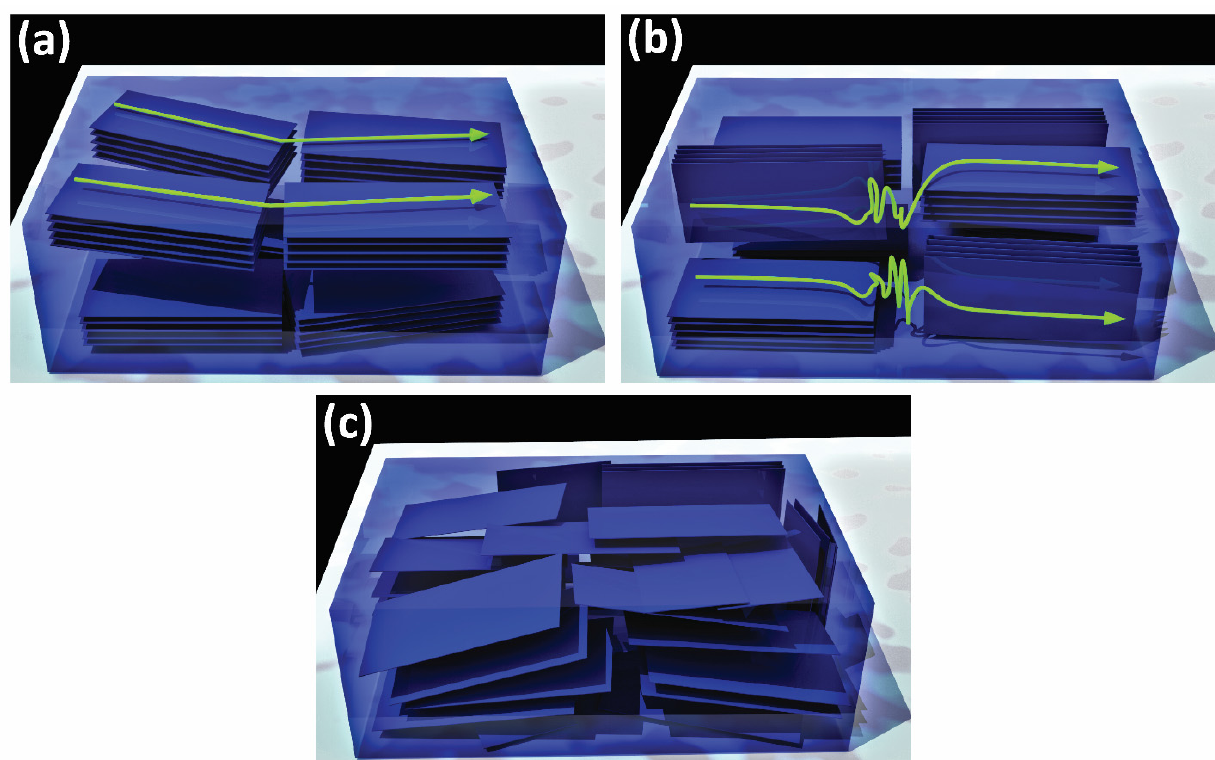
Figure 7. Schematic illustration of different textures and orientations in conjugated polymers: ( a ) preferential face ‐ on orientation; ( b ) mixture of face ‐ on and edge ‐ on orientations; and ( c ) random orientation [11]. The green arrow lines indicate possible charge carrier movement along the conjugated backbone. ( a – c ) Reproduced with permission [11]. Copyright 2021, De Gruyter.